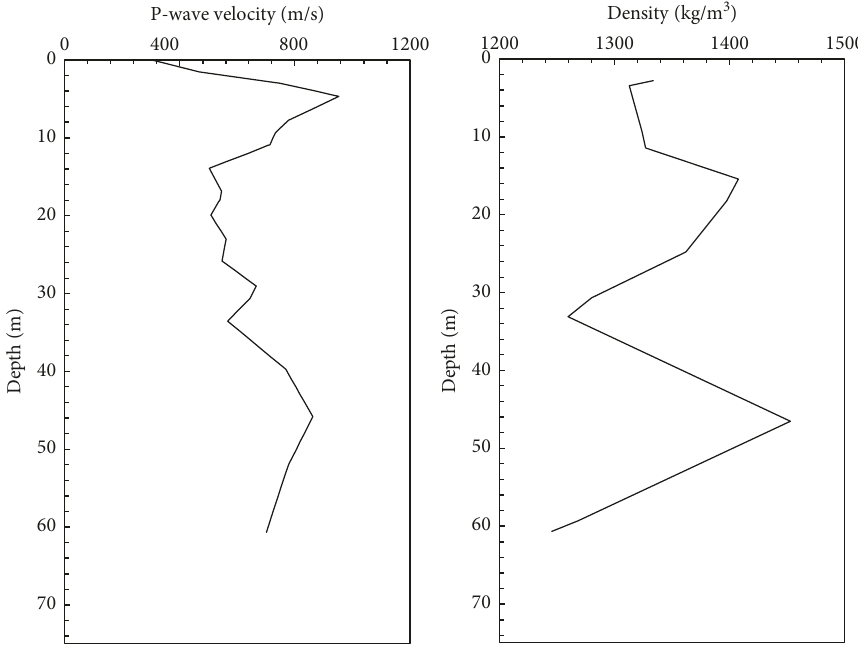
Figure 5: P-wave velocity and geomaterial density profile at Frenchman Flat, NTS